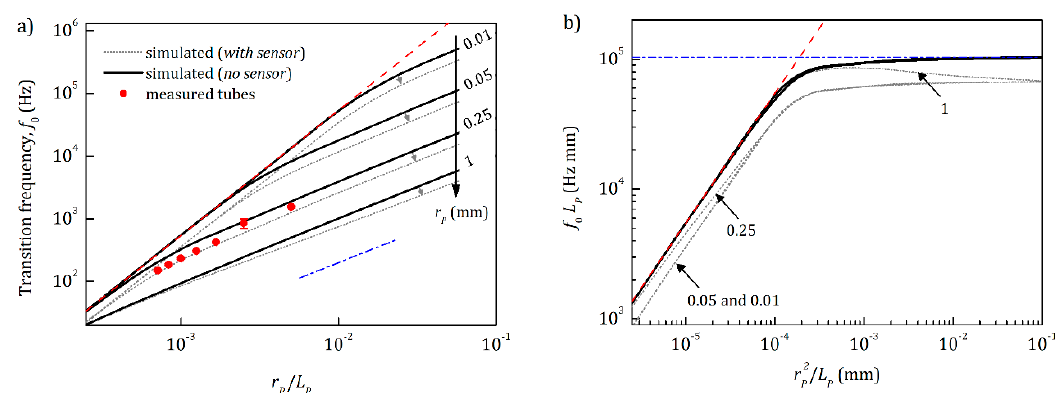
Figure 7. Transition frequency f 0 dependence on the relation between pore/tube radius r p and length L p . ( a ) Simulations of a pore/tube without (black solid lines) and with the sensor volume of 6.5 mm radius and 3 mm length (dotted gray lines). Red dots are measured data for the Teflon tube of 0.25 mm inner radius and of different lengths, partially presented in Figure 5a. The shift of f 0 to high frequencies in comparison to theoretically estimated values (dotted gray lines) is discussed in Figure 5b. Red dashed and blue dash-dotted lines show a quadratic and linear dependence, respectively. ( b ) The same data represented in different coordinates.